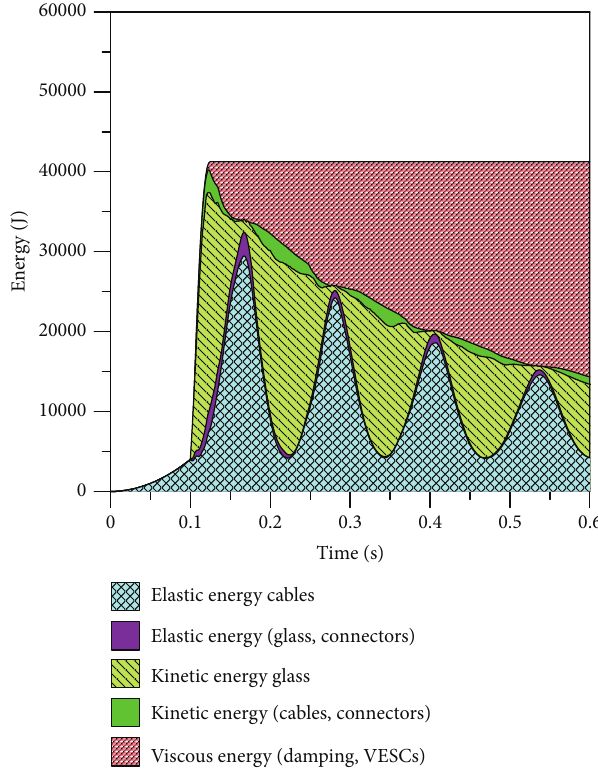
Figure 12: Energy terms for the fac¸ade-module not equipped by devices (ABAQUS).